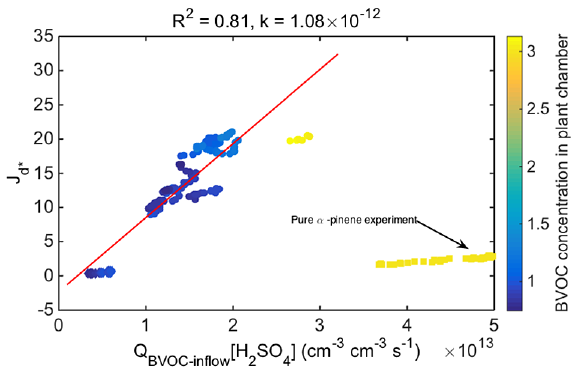
Figure 5. Particle formation rates ( J ) as function of the product of BVOC inflow and sulfuric acid concentration. Marker colours in- dicate the corresponding monoterpene concentration from the inlet flow of JPAC reaction chamber. The pure α -pinene experiments in- dicated in the figure were not included in the linear